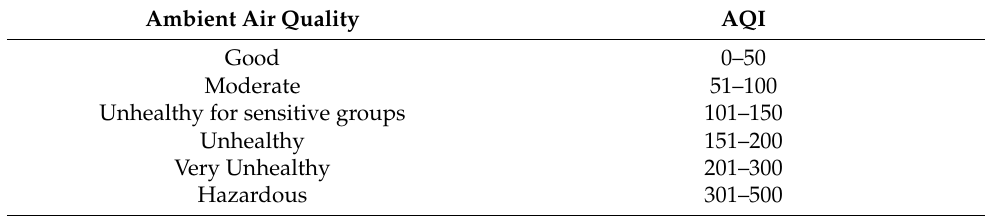
Table 1. Air Quality Index characterization